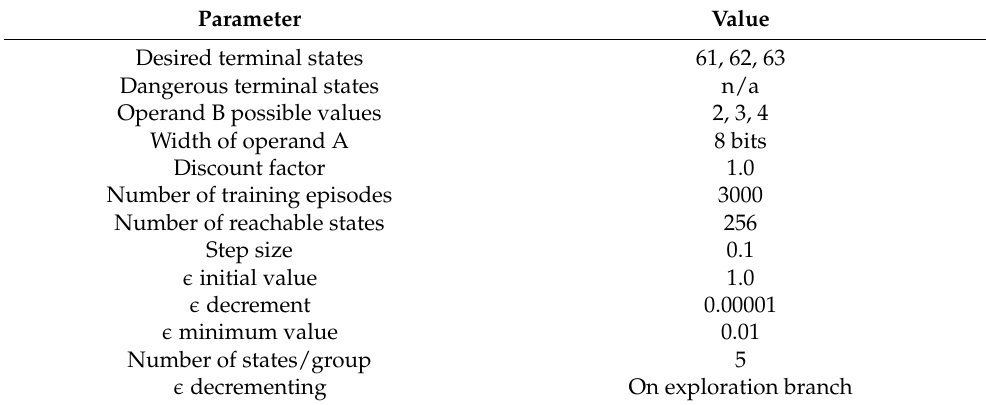
Table 10. Parameters used to configure the training processes for the 10 agents in focus in this section. Parameter Value Desired terminal states 61, 62, 63 Dangerous terminal states n/a Operand B possible values 2, 3, 4 8